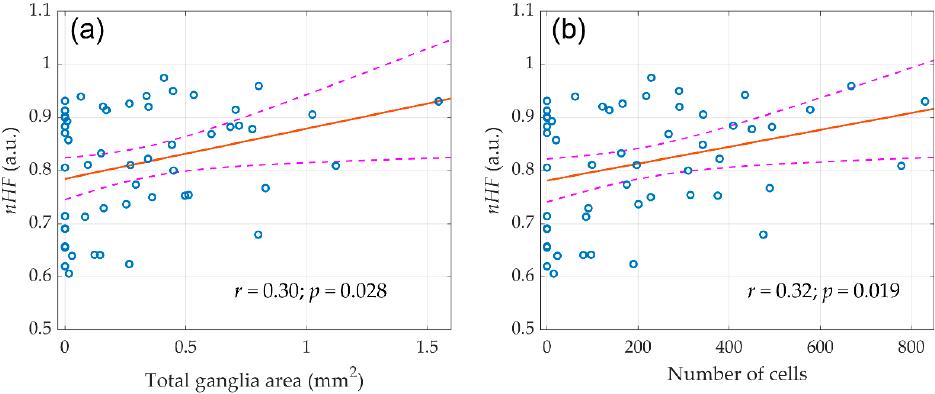
Figure 5. The linear regression between the initial (before any surgery) normalized high-frequency component (nHF) of the HRV spectra and morphological parameters of parasympathetic atrial ganglia. ( a ) Total ganglia area and ( b ) Number of cells. Blue circles show the measured values, the red line is the best fit for the data, and pink dashed curves represent a 95% confidence interval for the regression line.